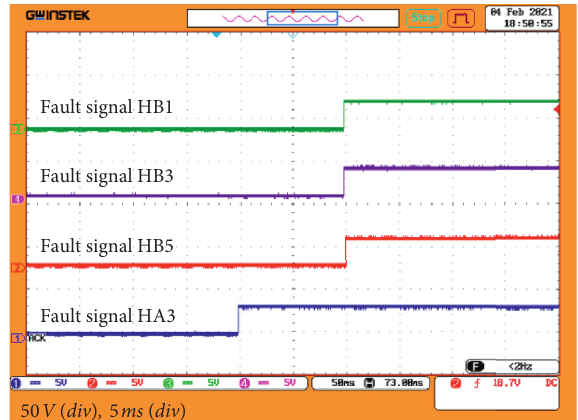
Figure 17: Fault signals on